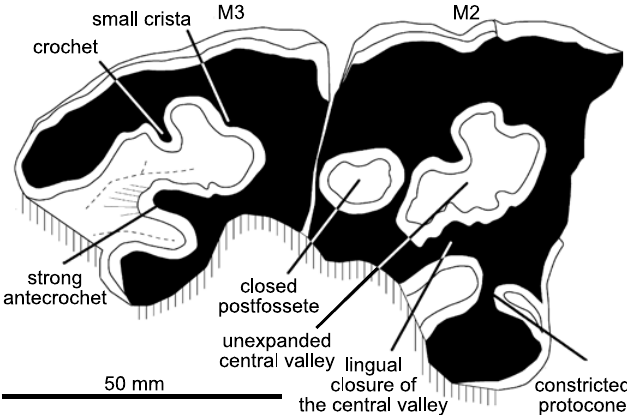
Fig. 2. Elasmotheriine rhinoceros Eoazara xerrii gen. et sp. nov. from the upper Miocene of Skoura, Morocco. Skull FSC-Sk-250, occlusal surface of right M2–M3; buccal is to the top, anterior to the right.